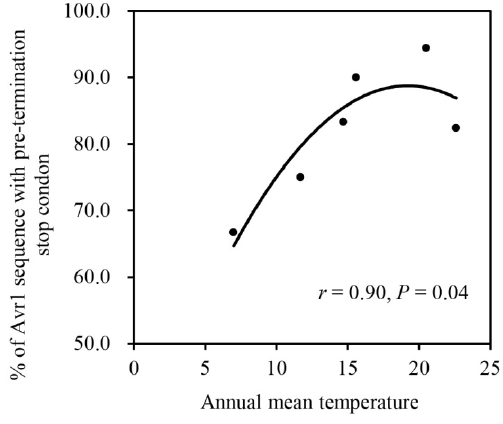
Figure 4. Correlation between the annual mean temperature in the collection sites and the frequency of Avr1 sequence with pre-termination stop codon.